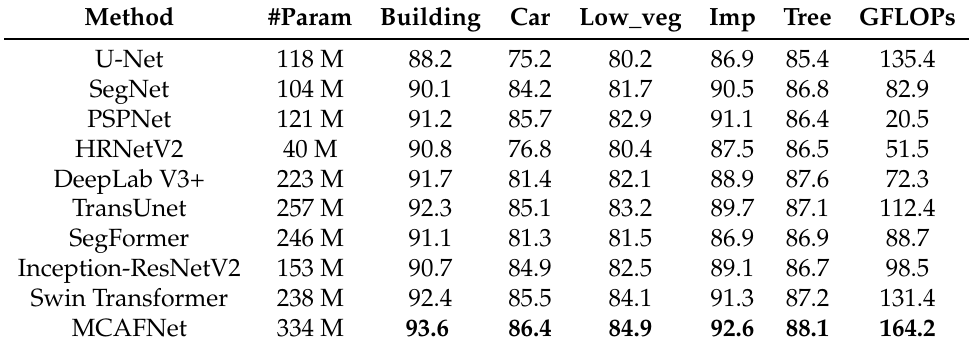
Table 3. Performance of ground objects interpreted by the different models on the Vaihingen